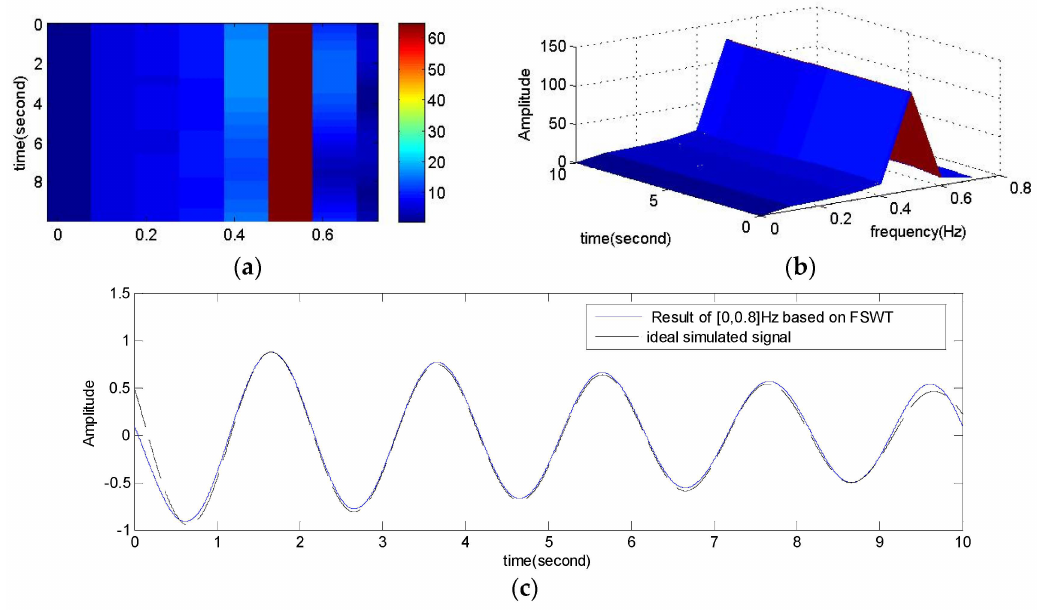
Figure 8. Fine analysis of frequency slice [0, 0.8] Hz based on FSWT. ( a ) FSWT 2D map; ( b ) FSWT 3D map; ( c ) Comparison of the reconstructed signal with the ideal